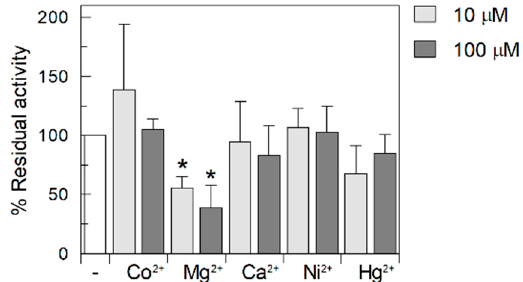
Figure 6. Effect of various divalent ion on riboflavin uptake. Transport was measured as described in Materials and methods. The two concentration of divalent ions were added 1 min before the labeled substrate. Riboflavin transport was stopped after 30 min. Percent of residual activity was calculated for each experiment with respect to the control sample (white bar) without added inhibitor and referred as 100%. The values are means ± SD from three experiments. Statistics was performed using Student’s t -test (* p < 0.05).